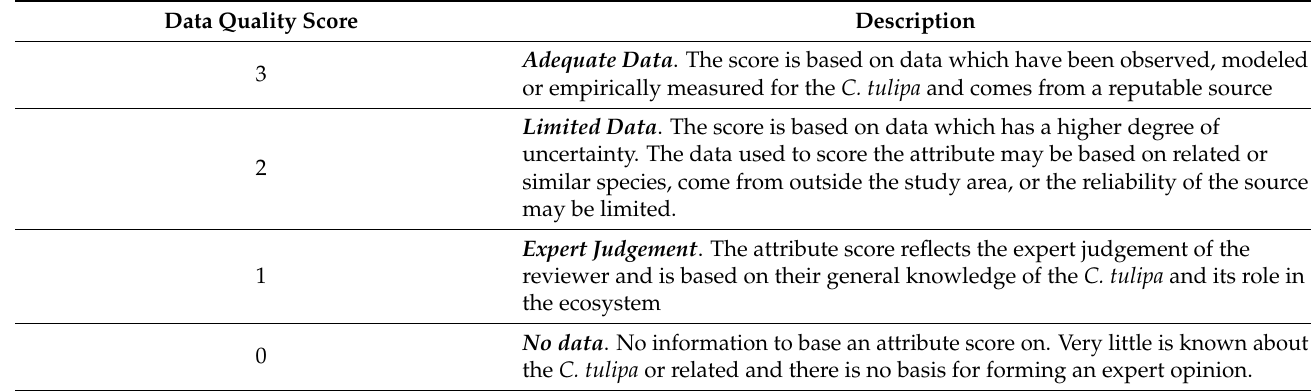
Table 4. Data quality scoring guidelines used in scoring the quality of expert scores (from [45]).